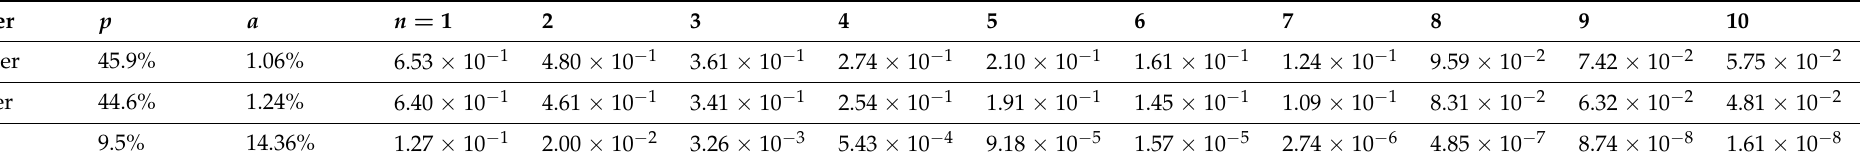
Table 1. The ROR probability obtained by applying the proposed model to each wager of baccarat.